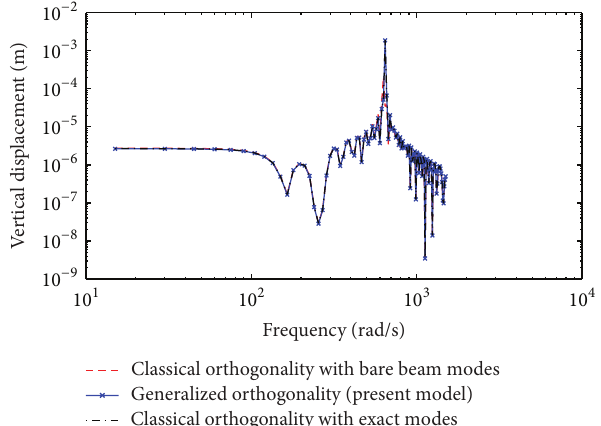
Figure 9: Frequency response of a simply supported beam carrying one in-span mass-spring-damper-mass system for 𝑘 = 190428 N/m, = 3.0775 kg, 𝑀 = 0 kg, 𝑇 = 0 N, 𝐸𝐼 = 63476.1 Nm 2 , 𝑐 𝑀 𝑑 𝑐 = 0.75 m. 0.1 Ns/m, and 𝐿 𝑑